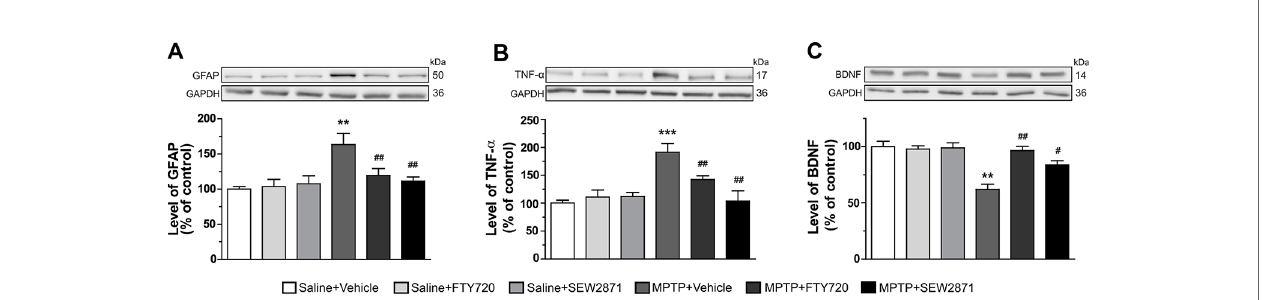
FIGURE 2 | Levels of in fl ammatory markers are affected in the striatum. Levels of GFAP (A) , TNF- a (B) , and BDNF (C) were assessed by Western blot in the striatum of mice. The data, expressed relative to GAPDH, represent the mean of relative optical density in triplicate experiments of GFAP, TNF- a , and BDNF (expressed as a percentage of control values) ± S.E.M., n = 3 – 5 mice/group. ** p < 0.01, *** p < 0.001 vs . vehicle + saline; # p < 0.05, ## p < 0.01 vs . vehicle +